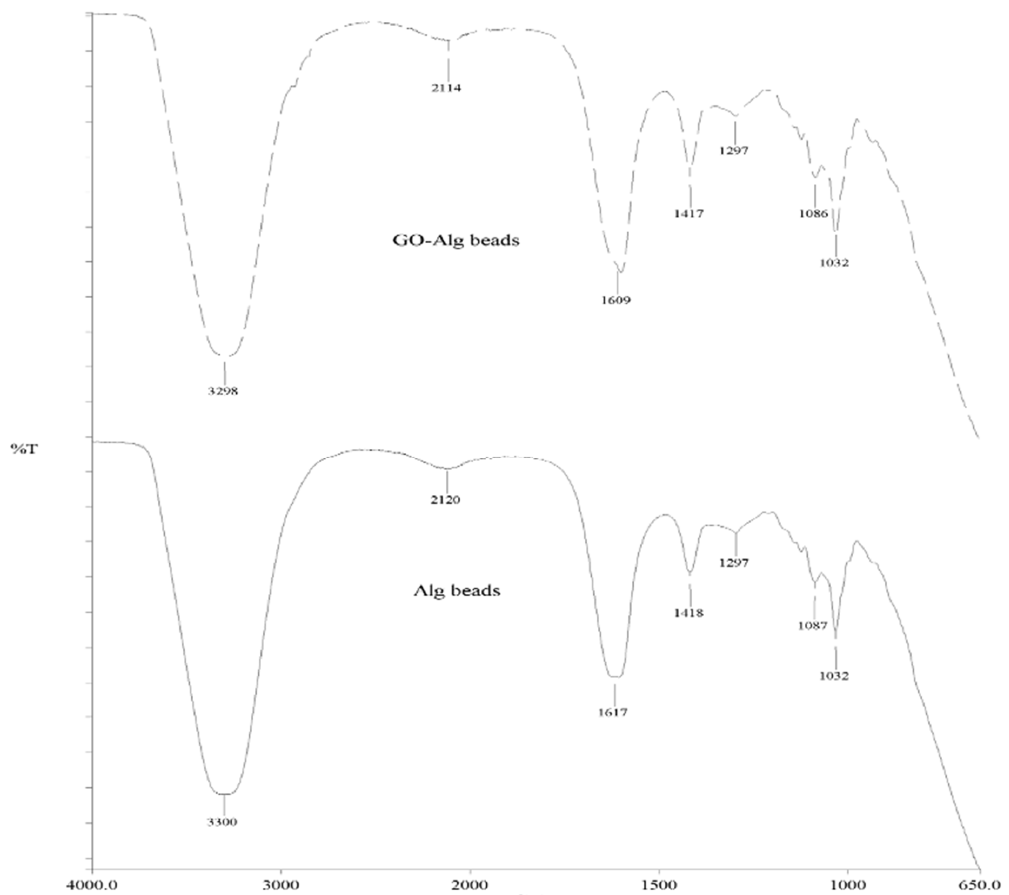
Figure A5. FTIR spectrum of Ca-Alg2 and Ca-Alg2/GO beads.